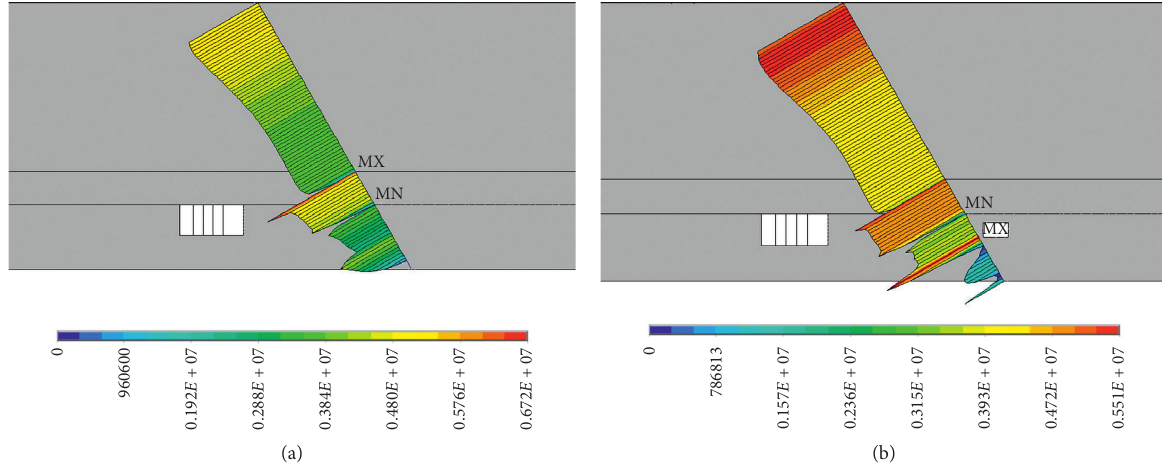
Figure 20: The nephogram of contact pressure when work face is far from the fault (forward direction fault). (a) Without searching tunnel [25, 26]. (b) With searching tunnel.